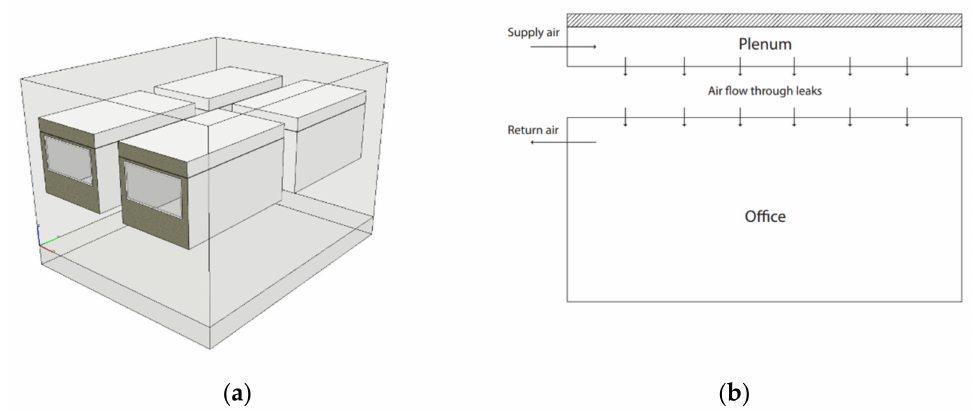
Figure 3. Parametric simulation model ( a ) contains 2 × 2 enclosures to simultaneously simulate meeting room and workstation space for two orientations; ( b ) division of enclosure into plenum zone and office zone. Table 1. Layers of the constructions in the model from the inside (top) to outside (bottom).